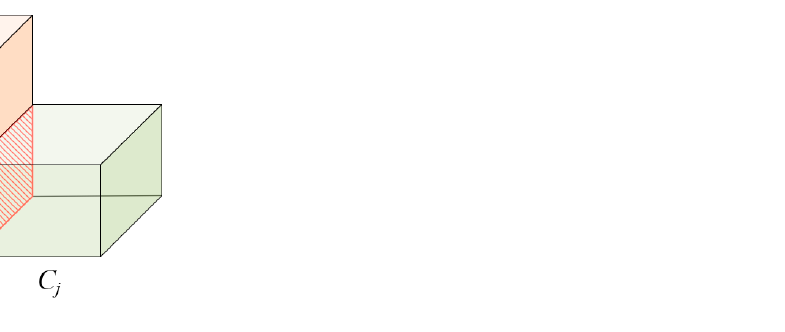
Figure 7. Illustration of a 3D facet F ij extracted from the interface between two cells C i and C j . The set of facets connected to pairs of cells is denoted as F 2 and those connected to